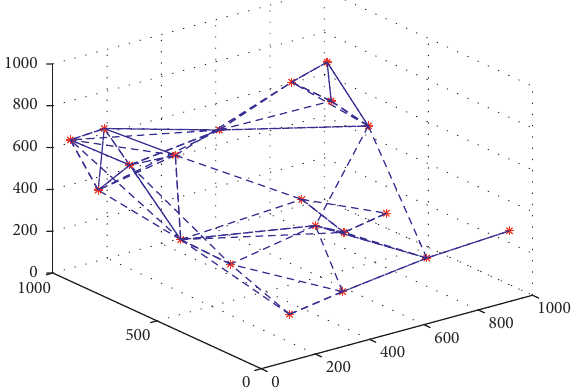
Figure 7: Illustration of the positions of nodes in a 20-node strongly connected network.